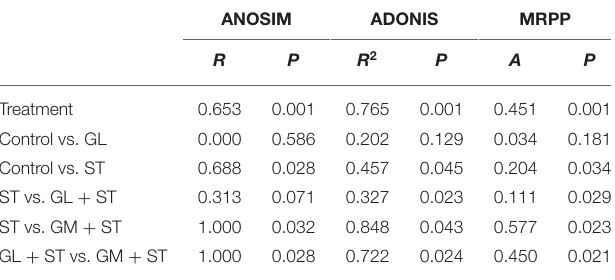
TABLE 2 | ANOSIM, PERMANOVA, and MRPP analysis of microbial diversity among different treatments ( n = 4/group). ANOSIM ADONIS MRPP